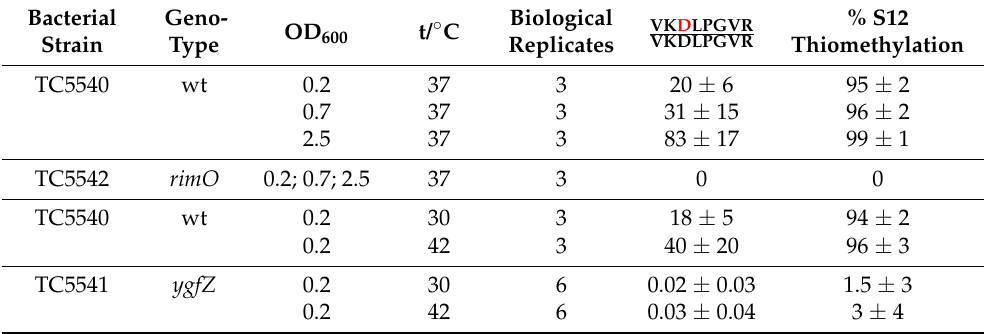
Table 3. Percent S12 thiomethylation in wild type (wt), rimO , and ygfZ bacterial strains grown at 30–42 ◦ C and harvested at different bacterial-growth phases (a,b,c) . Biological Bacterial Geno- % S12 VKDLPGVR OD 600 t/ ◦ C VKDLPGVR Replicates Strain Type Thiomethylation TC5540 wt 0.2 37 3 20 ± 6 95 ± 2 0.7 37 3 31 ± 15 96 ± 2 2.5 37 83 ± 17 99 ± 1 TC5542 rimO 37 0 TC5540 wt